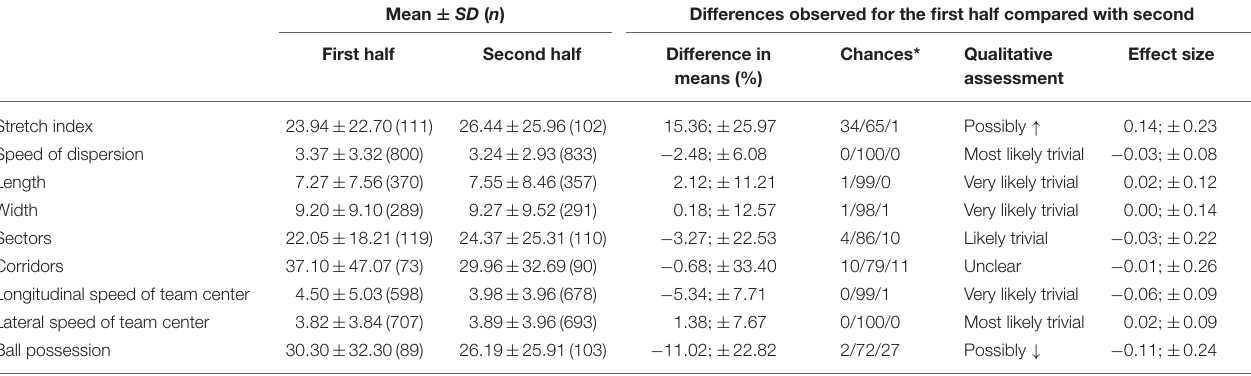
TABLE 2 | Mean values ± SD for different collective positional variables and ball possession and corresponding difference comparisons between first and second half. Mean ± SD ( n ) Differences observed for the first half compared with